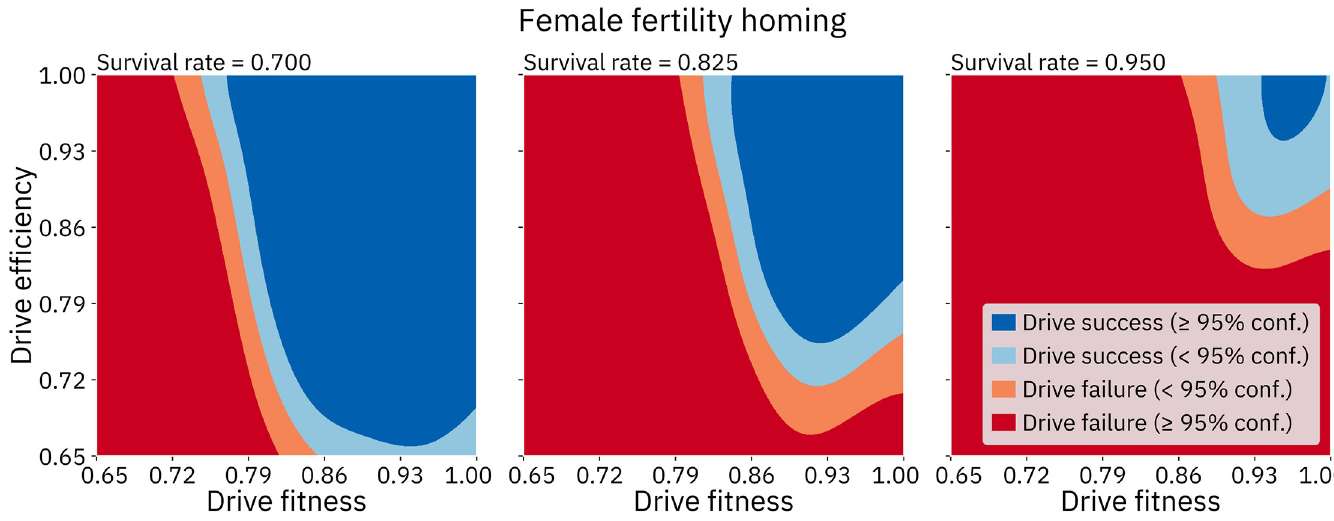
Fig 12. Female fertility homing drive with varying fitness, efficiency, and survival rate. Other parameters were fixed at default values.